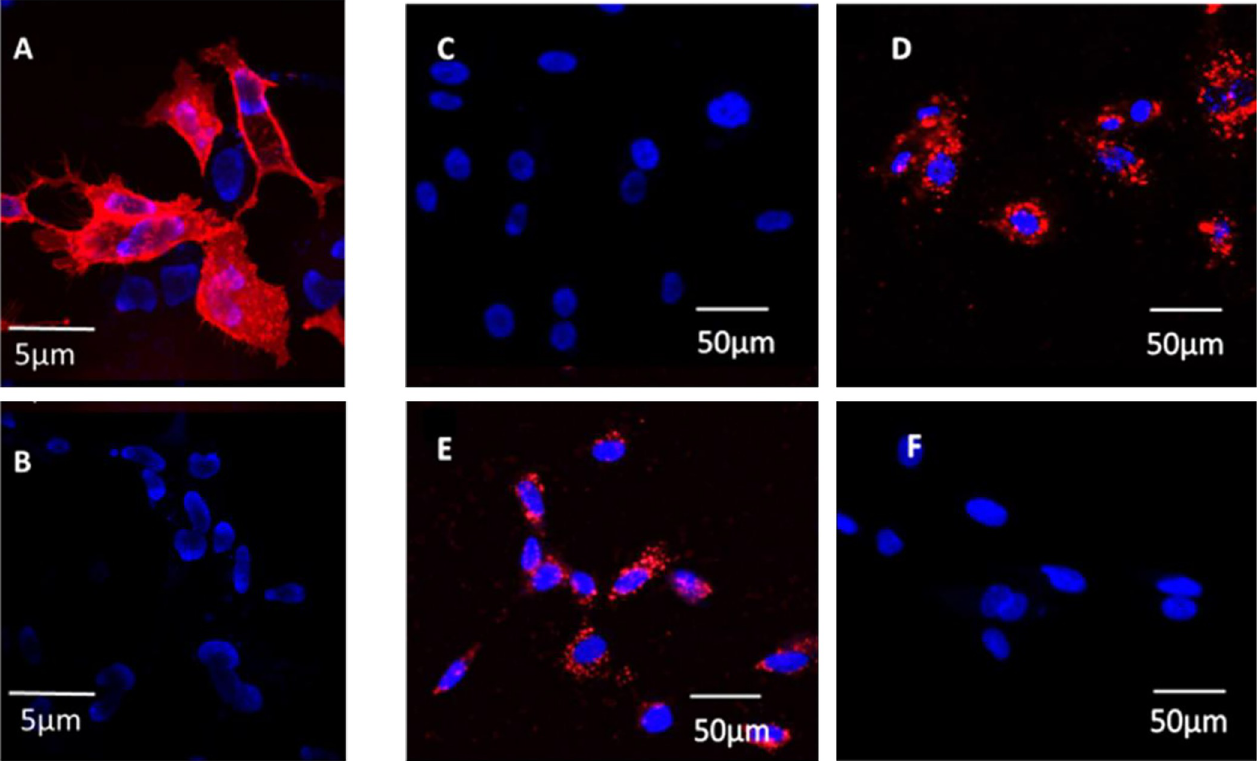
Fig 1. N/OFQ ATTO594 binding. HEK hNOP cells (positive control) loaded with Hoechts live cell nuclear dye (Blue) were incubated with 100nM N/OFQ ATTO594 this bound (A) in a SB-612111 sensitive manner (B). HUVEC also loaded with Hoechts dye (Blue) failed to bind 100nM N/OFQ ATTO594 (C). N/OFQ ATTO594 bound to the surface of HUVEC treated with 100ng/ml LPS and 100ng/ml PepG for 24 hours (D) and 48 hours (E). Binding of N/OFQ ATTO594 was prevented by 1 μ M SB-612111 (F; illustrated at 24 hour time point). Images are representative of 49 individual cell lines with experiments carried out in duplicate.